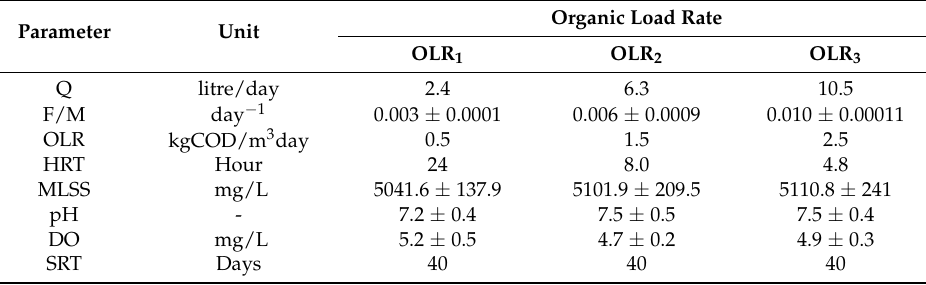
Table 1. Operating parameters of MBR-NF model during testing period.